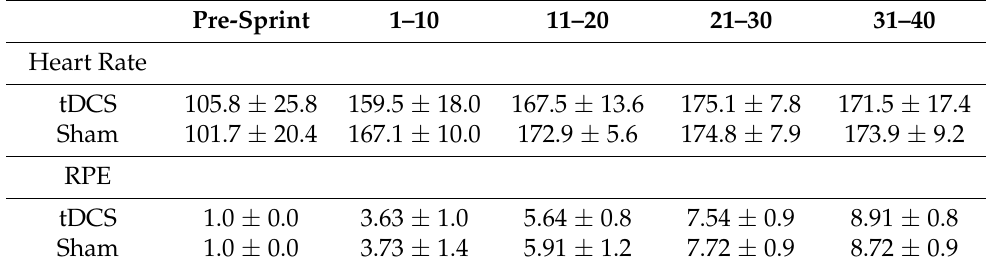
Table 1. Heart rate during sprinting and RPE score. Values are mean ± SD, n = 13. tDCS, transcranial direct currentstimulation group; Sham, Sham group.